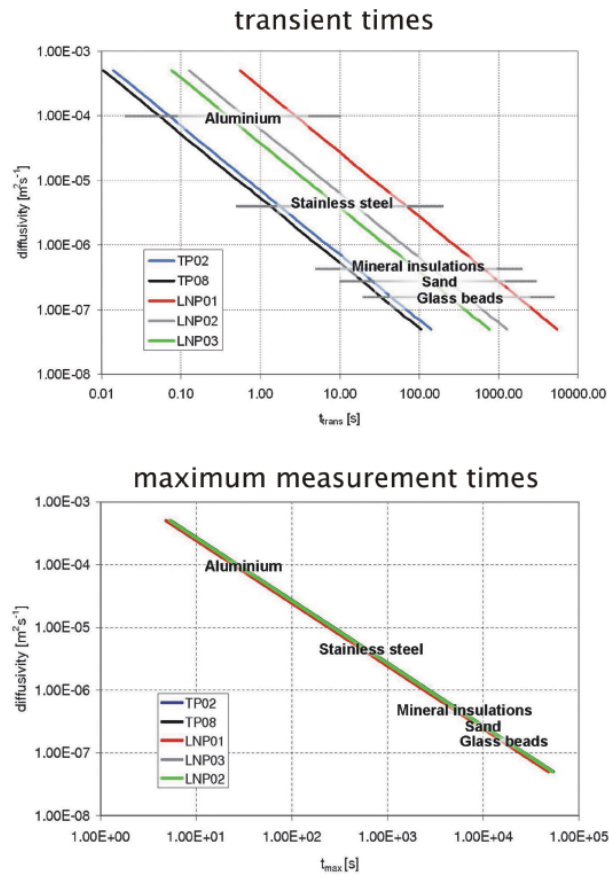
Fig. 5. Transient times and maximum measurement times calculated for the five investigated thermal probes using a diffusivity